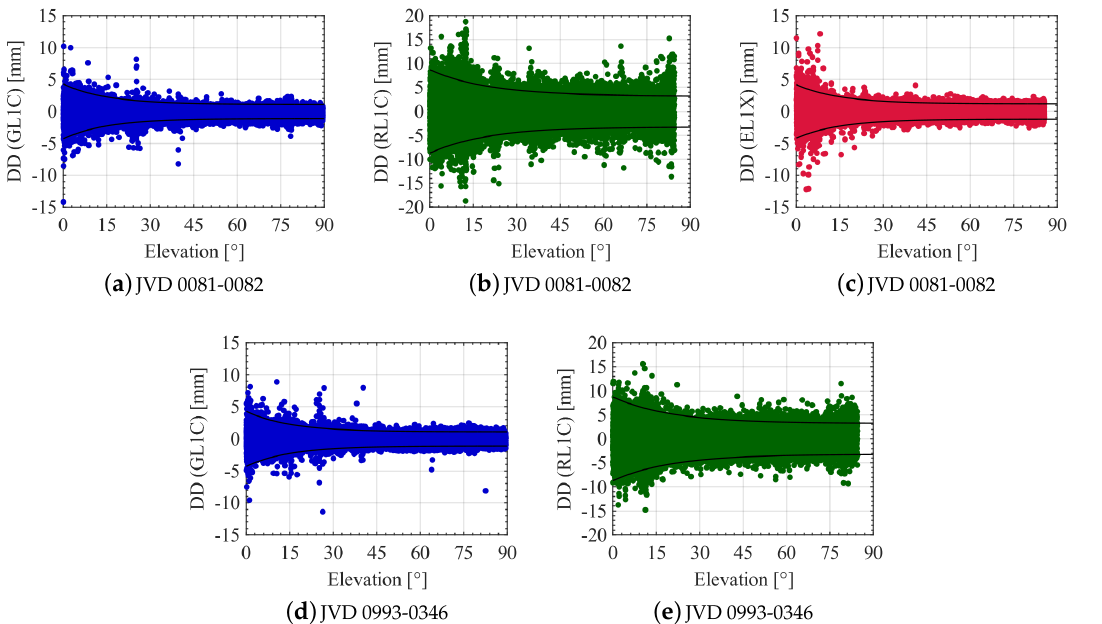
Figure 15. DDs of L1 carrier phase observations for different receiver combinations with respect to the satellites elevation angles. GPS, GLONASS and Galileo noise levels are shown in blue, green and red colours respectively. Solid black curves represent exponential functions that fit to the estimated DDs.